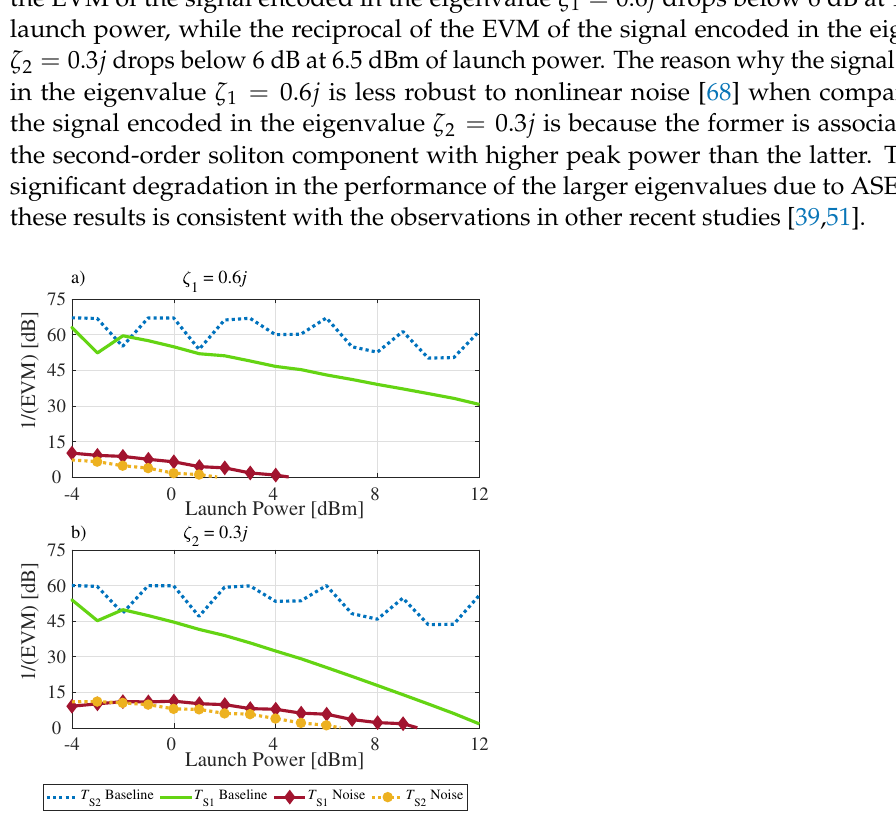
Figure 13. The reciprocal of the EVM as a function of the launch power when the system includes only ASE noise from EDFAs. ( a ) Results of the signal decoded from the first eigenvalue ζ 1 = 0.6 j . ( b ) Results of signal decoded from the second eigenvalue ζ 2 = 0.3 j